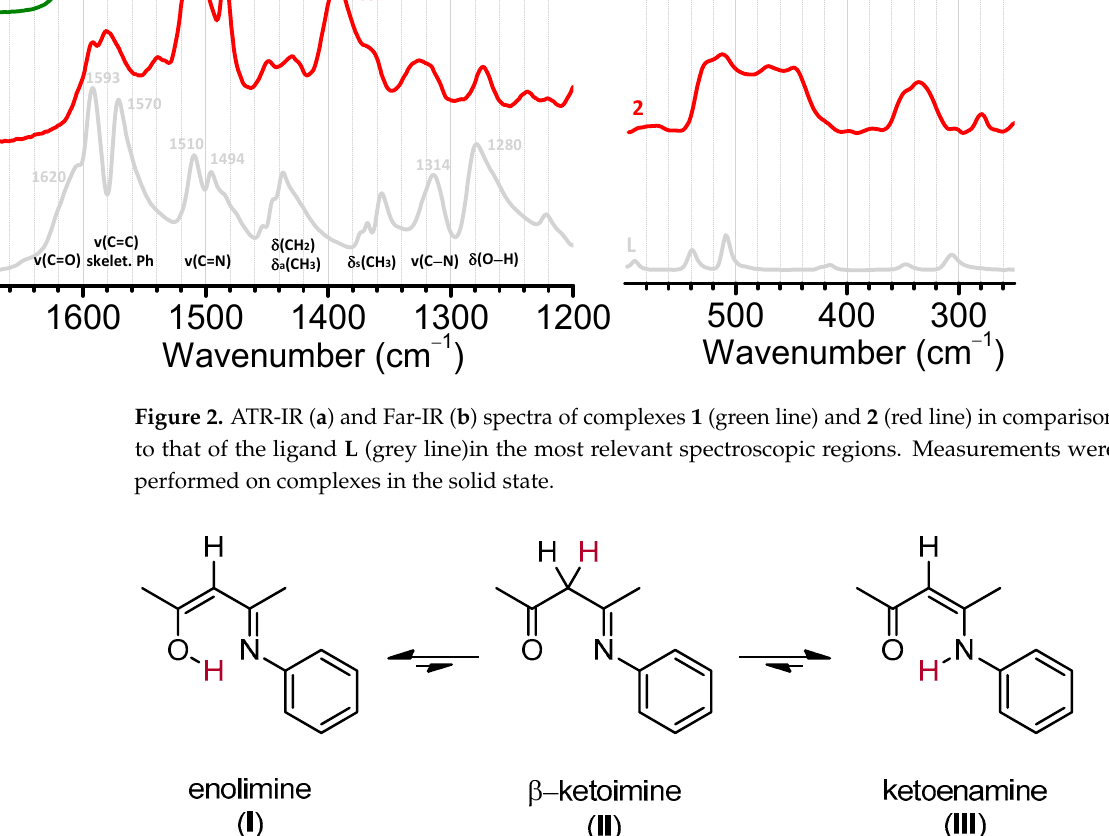
Figure 3. Tautomers of L ligand: structures I and III containing –OH and –NH groups are greatly stabilized by intra- and intermolecular hydrogen bonding and are expected to be predominant.